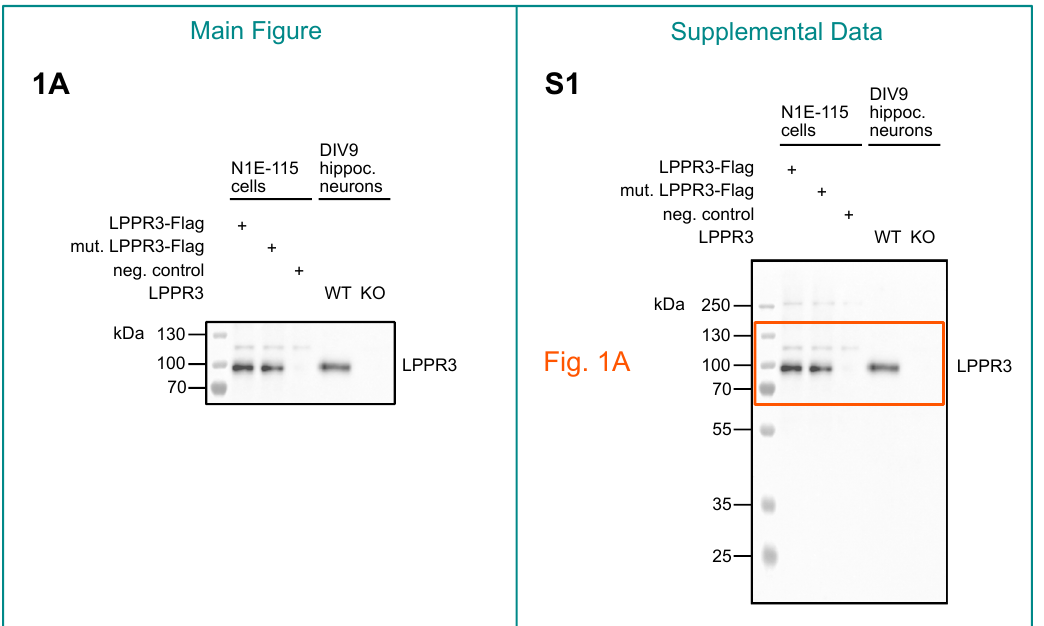
Fig 5. Western blot image minimal reporting standard. Published western blots should show a minimum of 2 molecular weight marker bands of different weights if the protein of interest falls between the molecular weight marker bands, and 3 molecular weight marker bands of different weights if the protein of interest is directly at one of the marker bands. The molecular weight markers should be annotated with labels. An original, uncropped image of each blot should be published in the supplement or deposited on a public repository. The source data blot should be named in a way that links it to a specific figure, panel, and protein. The outline of the crop should be annotated on the original image. For the unprocessed image, see S1